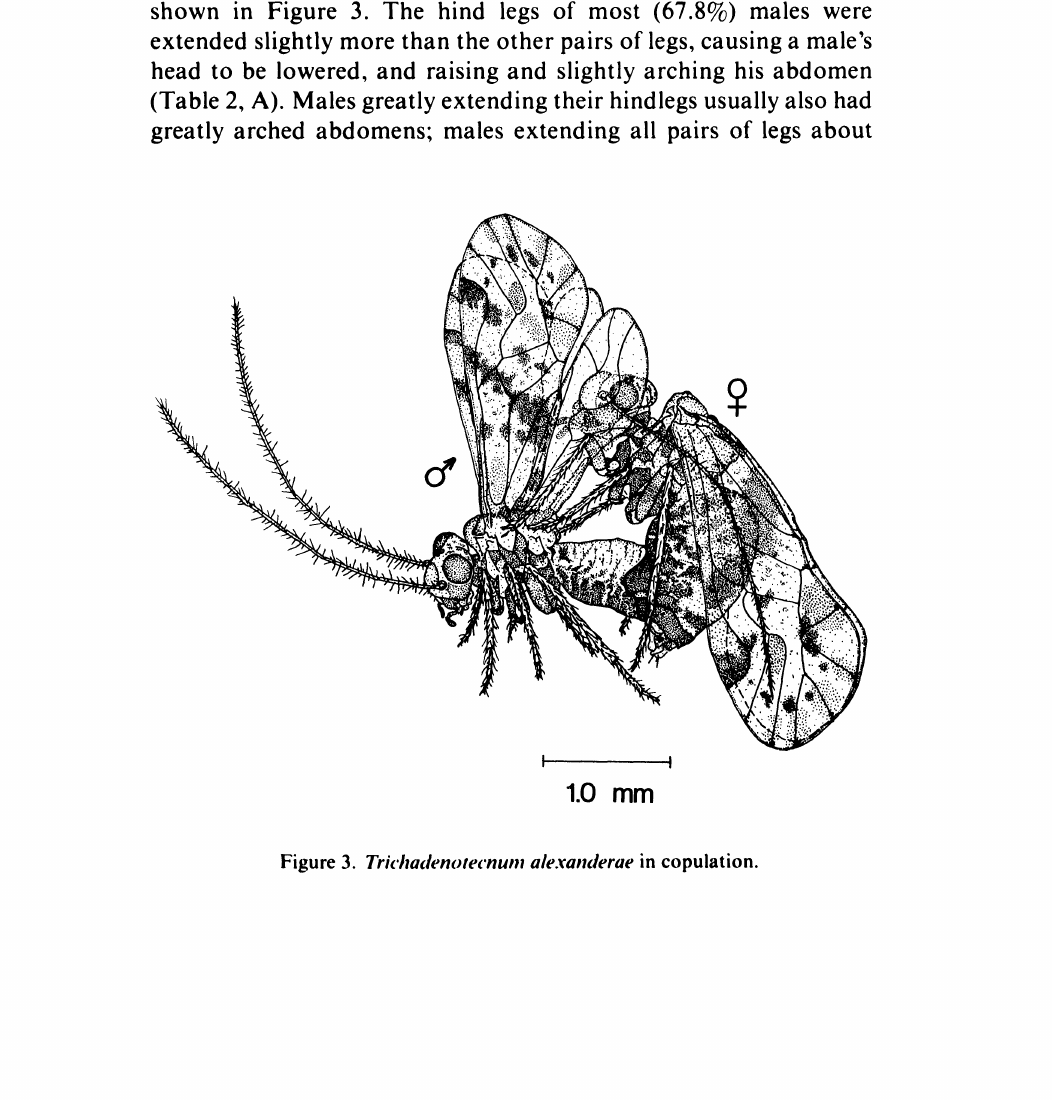
Figure 3. Trichadenotecnum alexanderae in